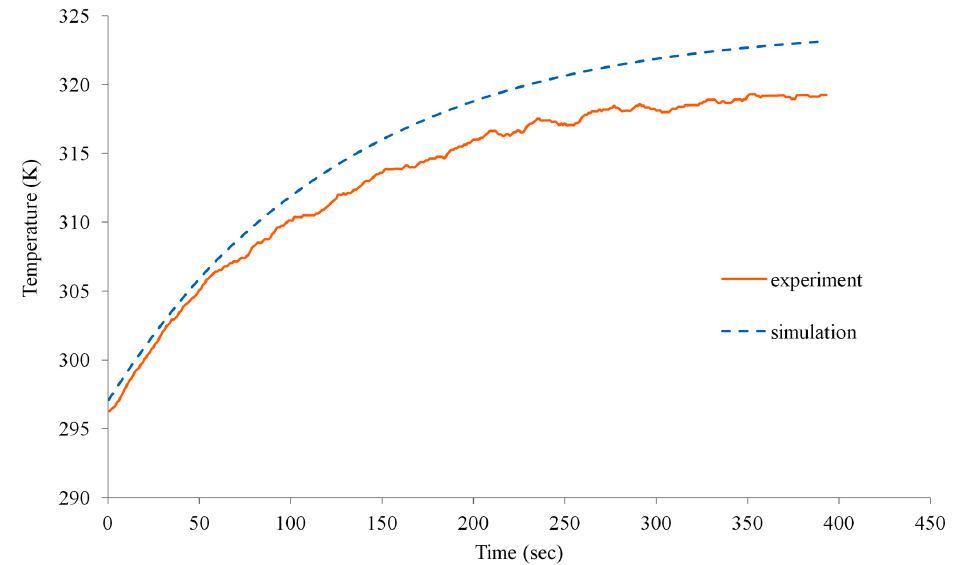
Figure 12. Variation of the sink temperature under a flux of 1250 W/m 2 for a heat sink without PCM.